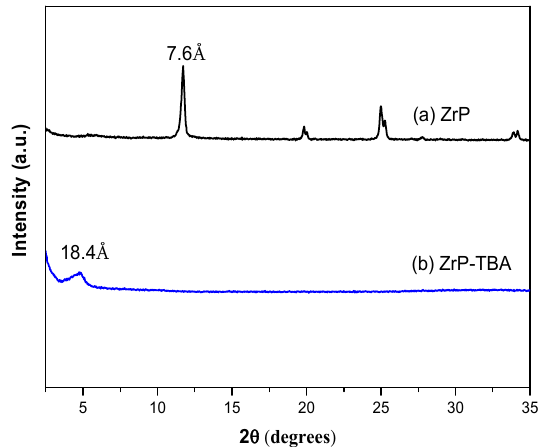
Figure 3. X-ray diffraction (XRD) pattern of ( a ) ZrP and ( b )exfoliated ZrP nano platelets.